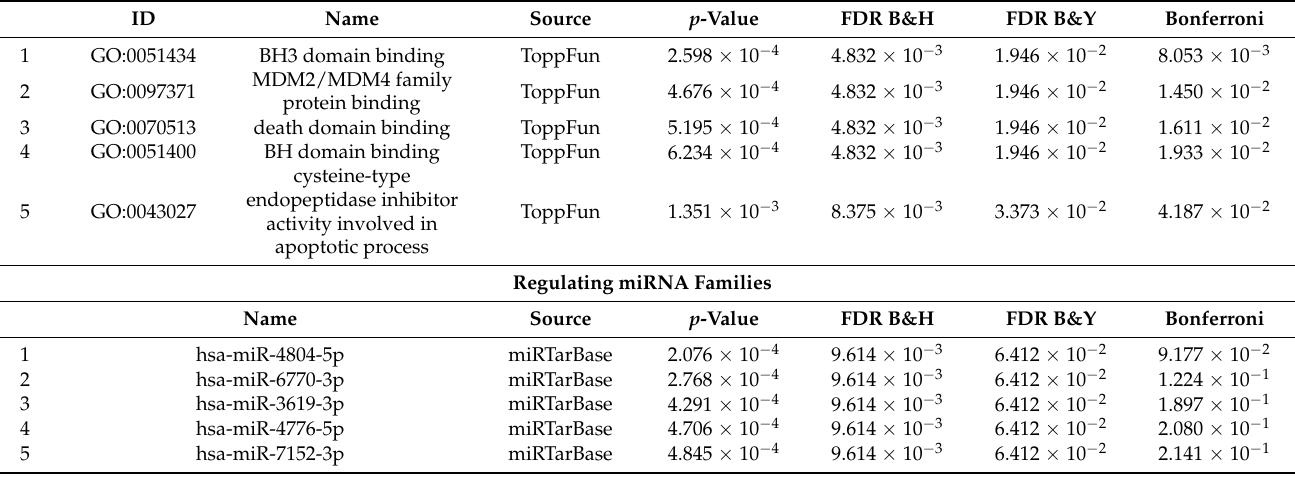
functions and regulating miRNA families are